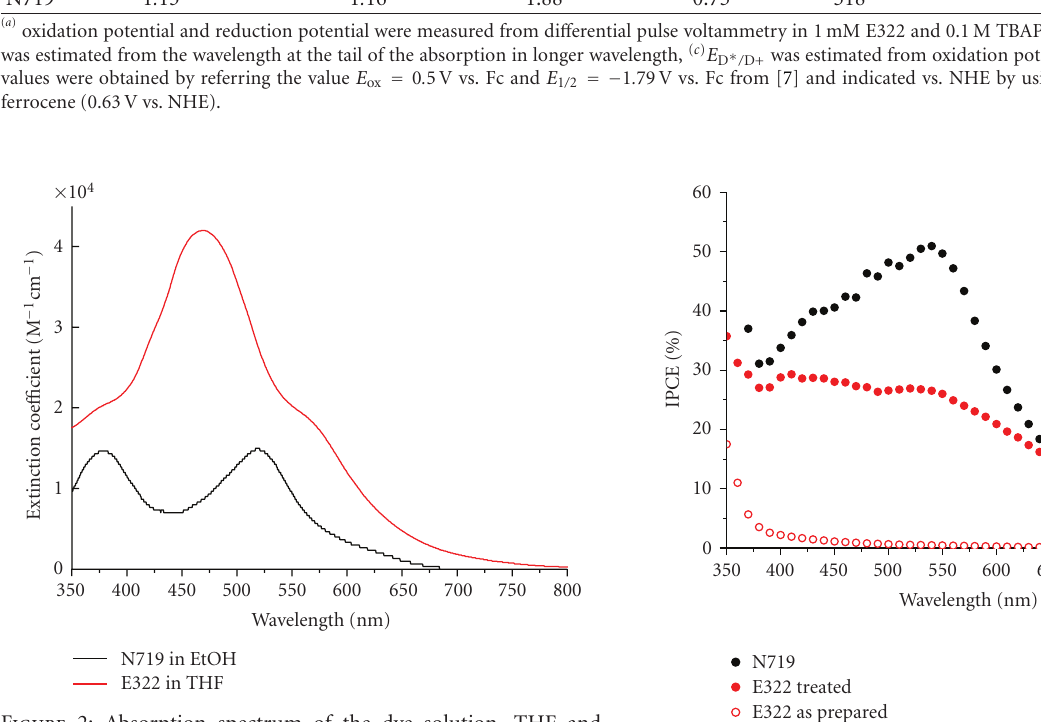
Figure 2: Absorption spectrum of the dye solution. THF and ethanol were used as solvent for E322 and N719, respectively. Table 2: Photovoltaic performance of dye-sensitized solar cells with E322 and N719, respectively.